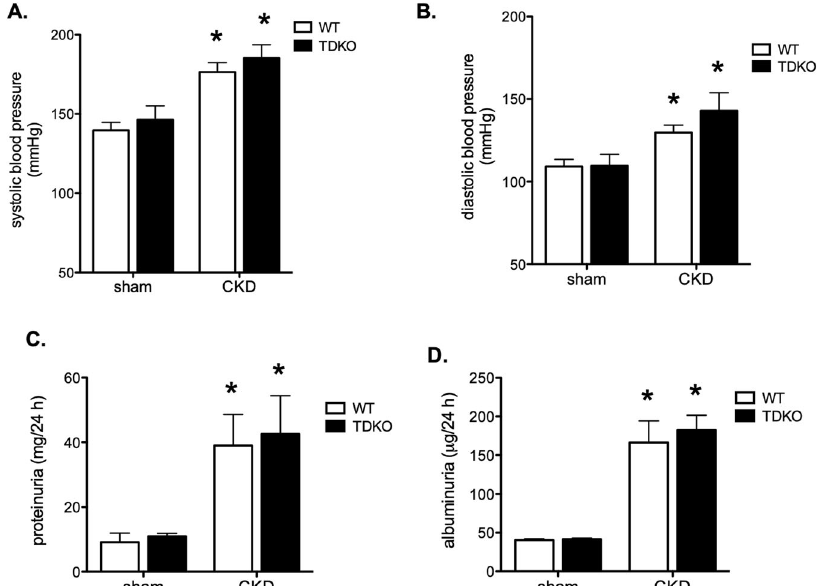
Fig. 2 Knock out of TDAG51 does not protect against risk factors for kidney disease. Blood pressure was measured in WT and TDKO mice with or without chronic kidney disease (CKD). Systolic ( A ) and diastolic ( B ) blood pressures are increased in mice with CKD; no difference was found between WT and TDKO animals. Proteinuria ( C ) and albuminuria ( D ) are also increased in animals with CKD; knock out of TDAG51 had no effect on proteinuria or albuminuria levels. * P < 0.05 vs